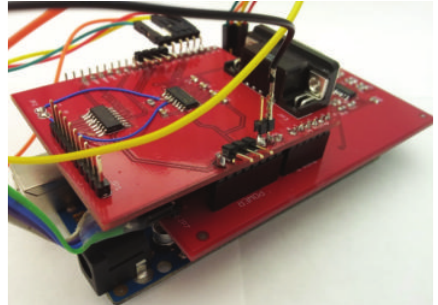
Figure5:SimplifiedJ1772EVSEcontrollerwithoutZigBeefunction. (1) RS232 module. (2) Pilot signal generator/monitor. (3) Aduino